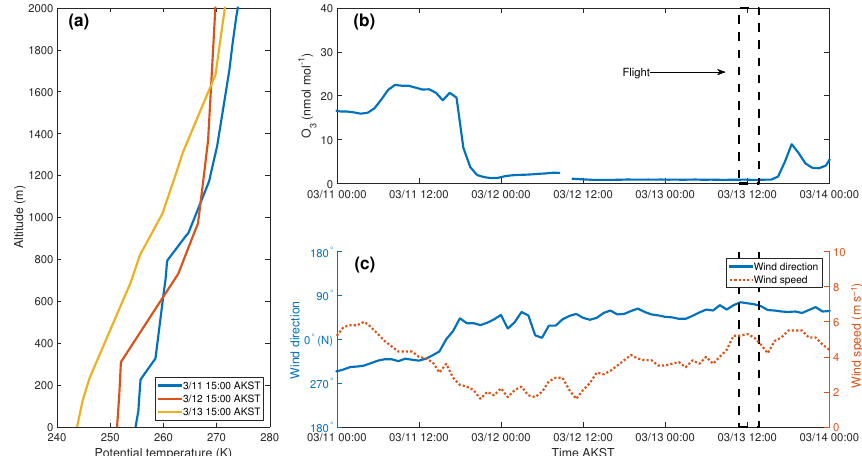
Figure 5. Meteorological and in situ ozone measurements at Utqia ˙ gvik. (a) Daytime soundings from the Utqia ˙ gvik airport. (b) Near-surface ozone mole fractions from the NOAA/GMD Barrow Observatory. (c) Wind speeds and directions from the NOAA/GMD Barrow Observatory. In panels (b) and (c) , dashed rectangles indicate when the flight took